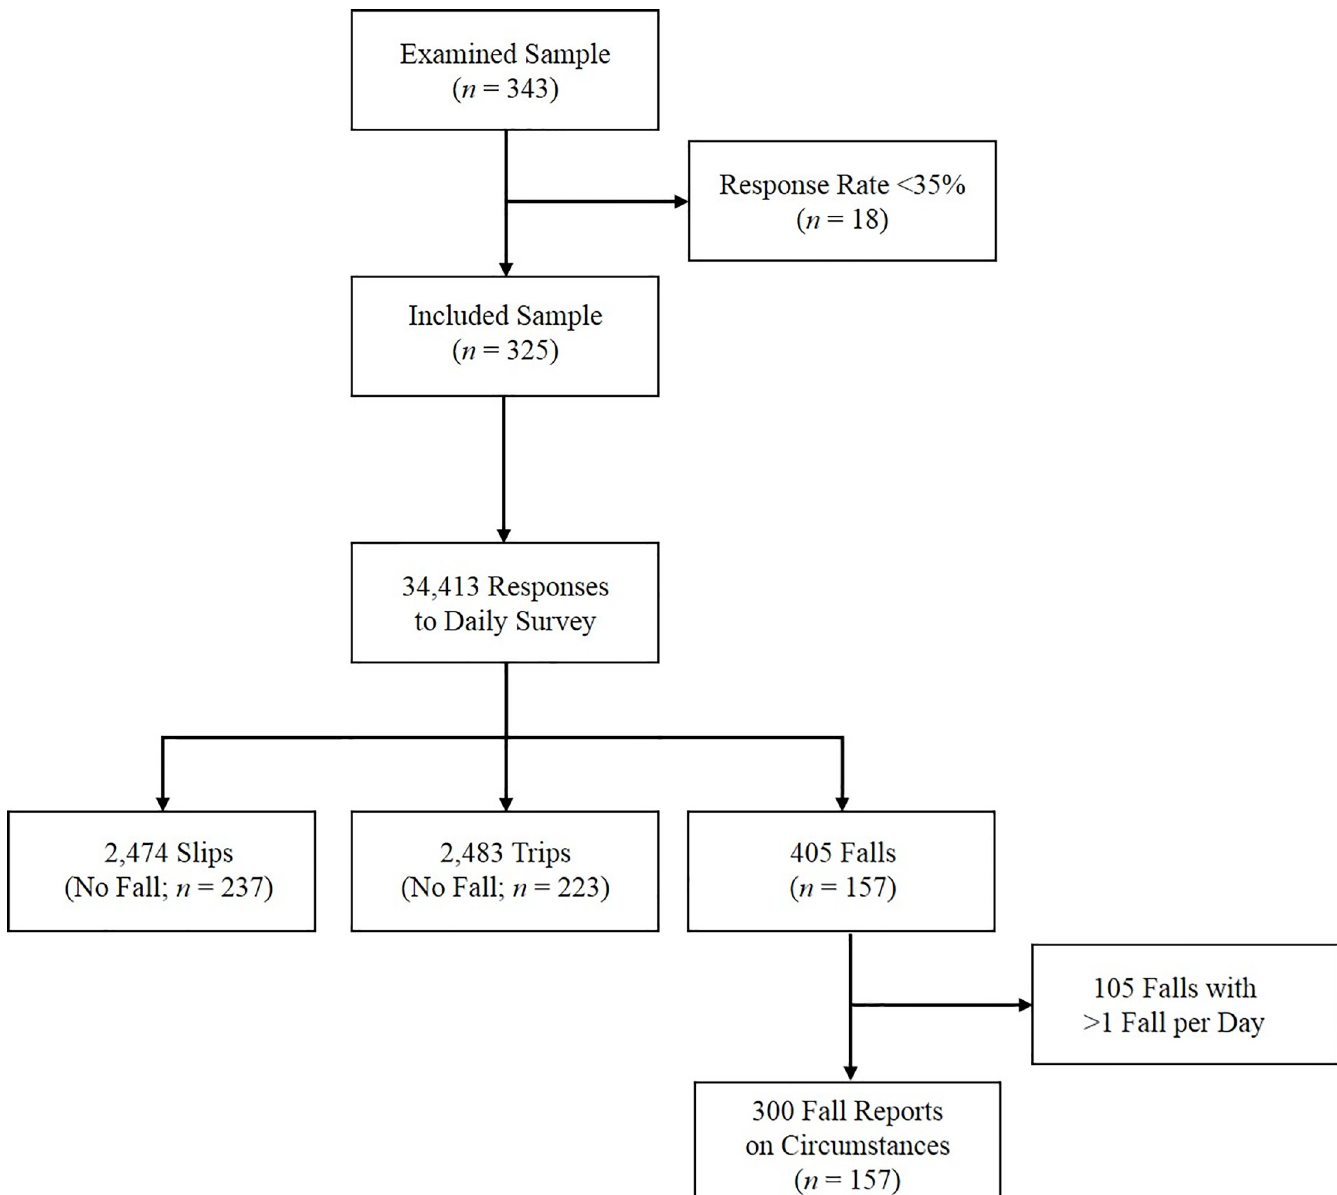
Fig 2. Participant flow diagram. Figure also includes the number of responses to the daily survey, number of slips and trips reported without a fall, number of falls, and number of reports on fall circumstances.